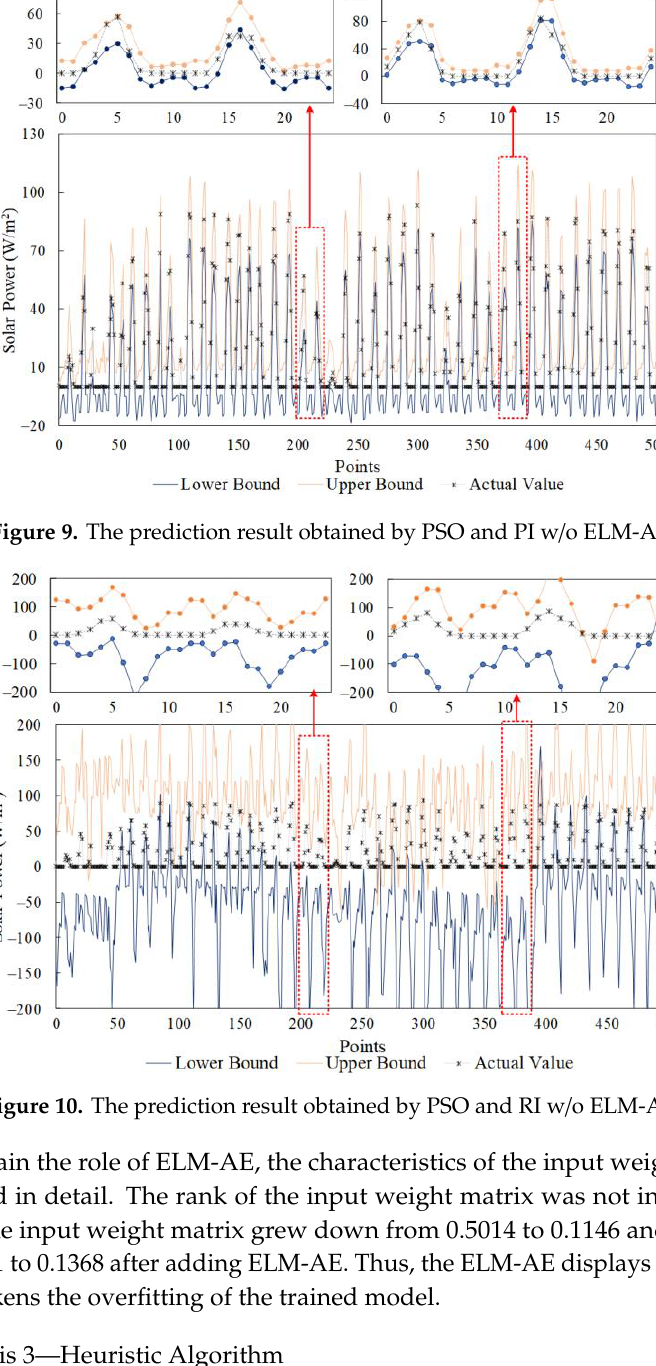
Figure 8. The prediction results obtained by PSO and WI w/o ELM-AE.